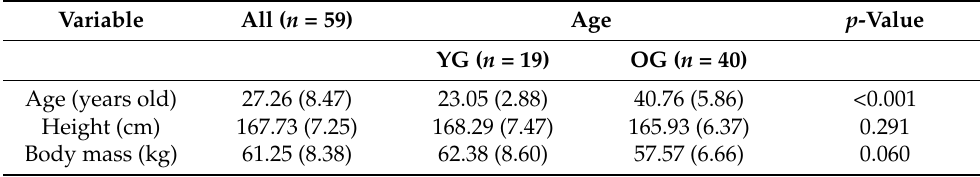
Table 1. Participants descriptive data (mean ±